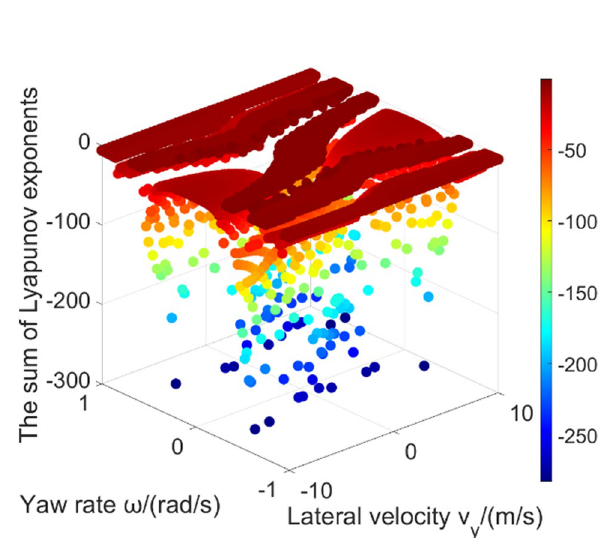
Figure 11. Sum of Lyapunov exponents (> − 300) in the global region on low adhesion